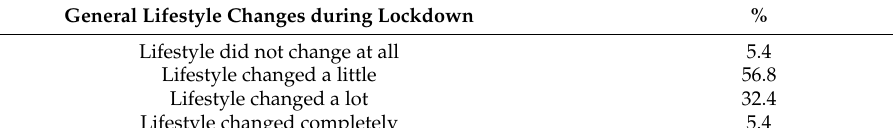
Table 2. Lifestyle Changes During